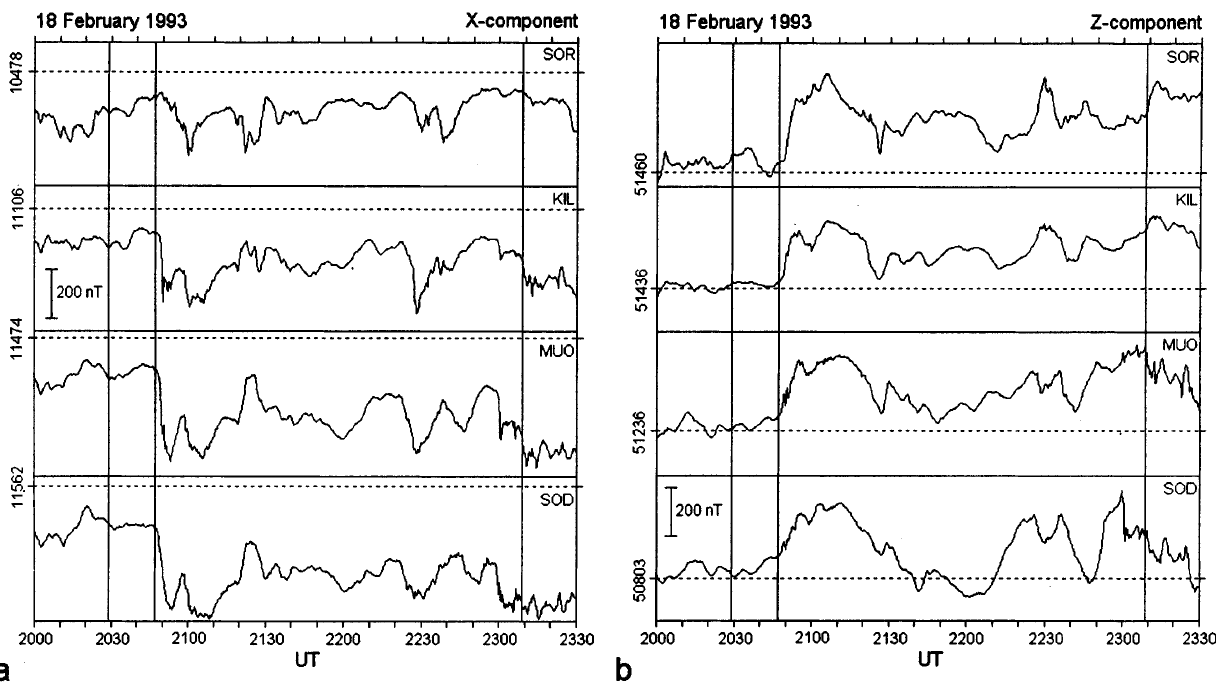
Fig. 2a, b. High-latitude magnetograms from the Scandinavia during the intervals studied: a X components, b Z components. The times of the aurora arc enhancement are marked with vertical solid